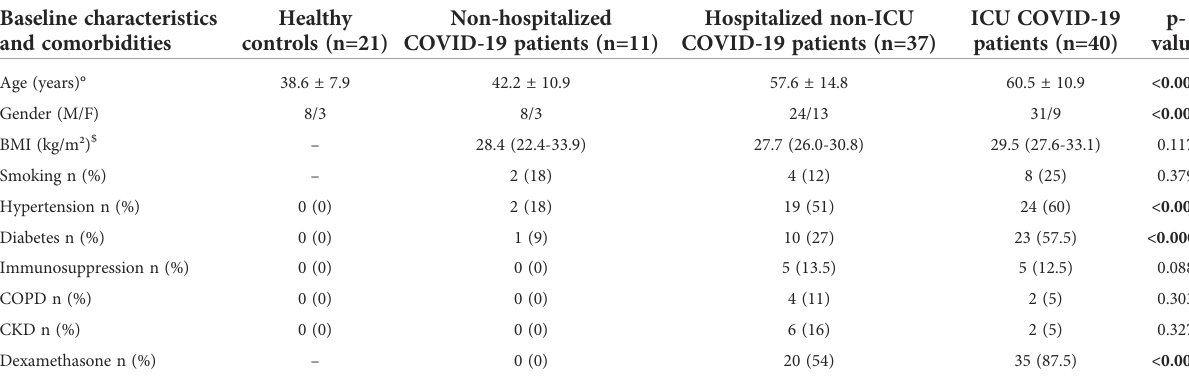
TABLE 1 Baseline characteristics and comorbidities.